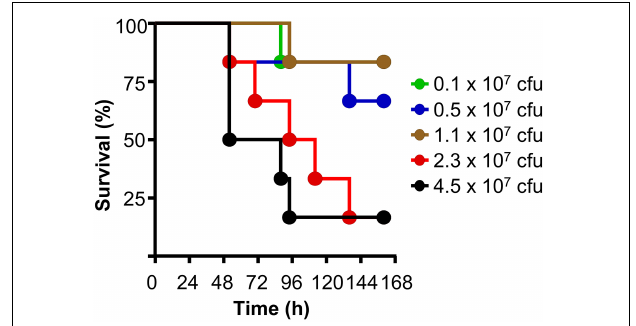
FIGURE 5 | The animal model of pneumococcal infection. Survival curves of mice infected with different doses of pneumococci. The data are combined from two separate experiments with six to eight mice for each dose of pneumococci in each